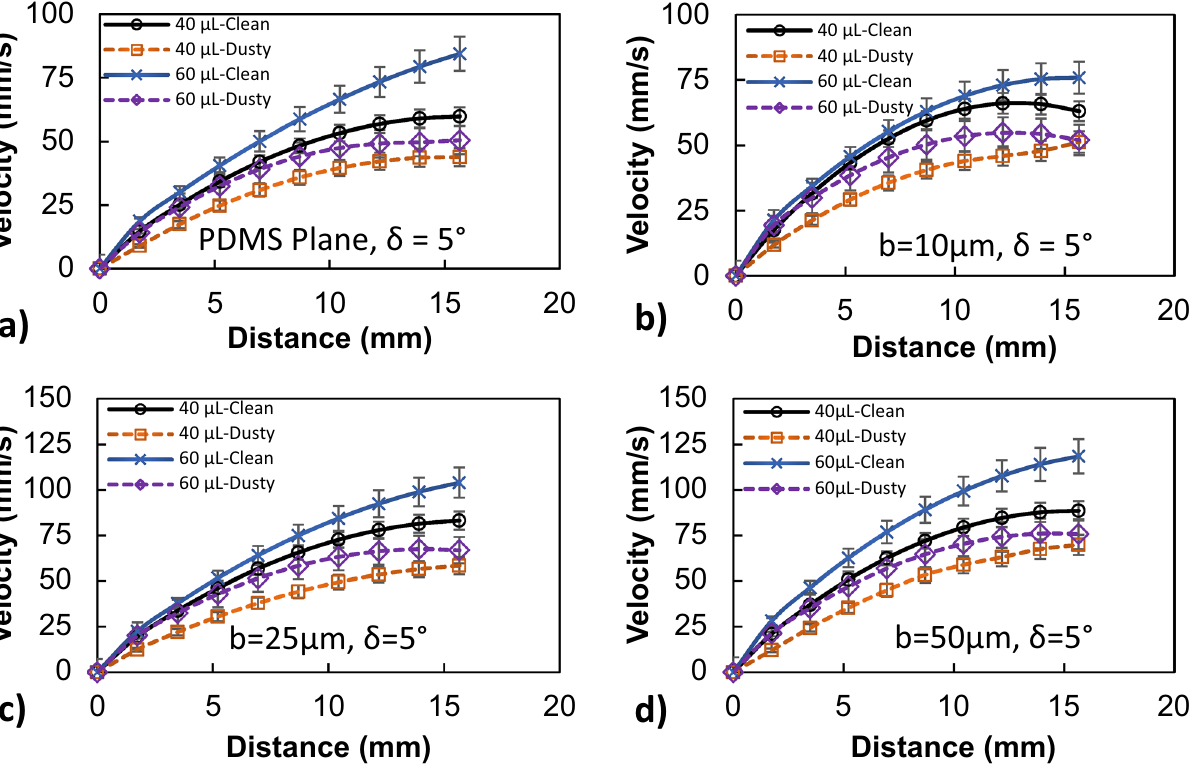
Figure 11. Droplet translational velocity obtained from experiment due to dusty and clean surfaces for two droplet volumes and various micro-post gap